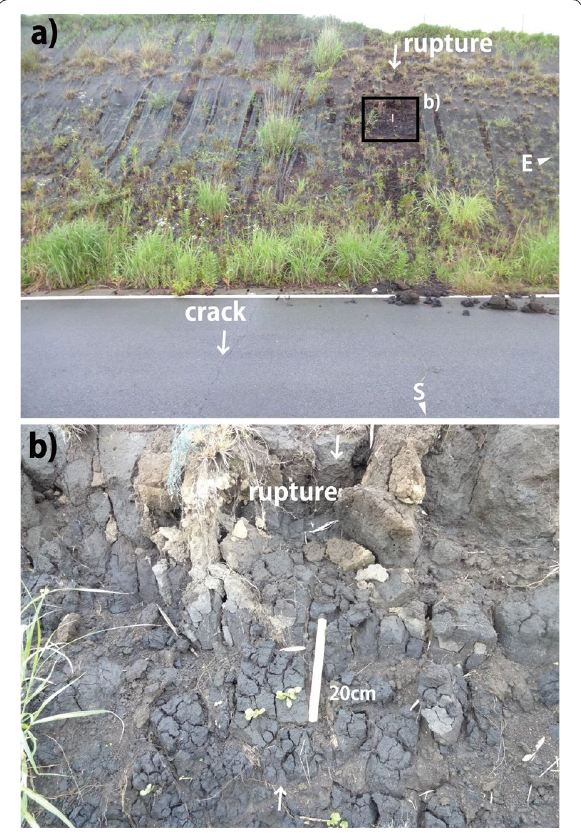
Fig. 4 Surface rupture near Aso Farm Land. a Earthquake rupture appearing in the outcrop at Site 8; b Rupture in outcrop observed at the surface with N34°E strike and 80°S dip. Some ruptures exhibit the same strike and dip in this outcrop at Site 7